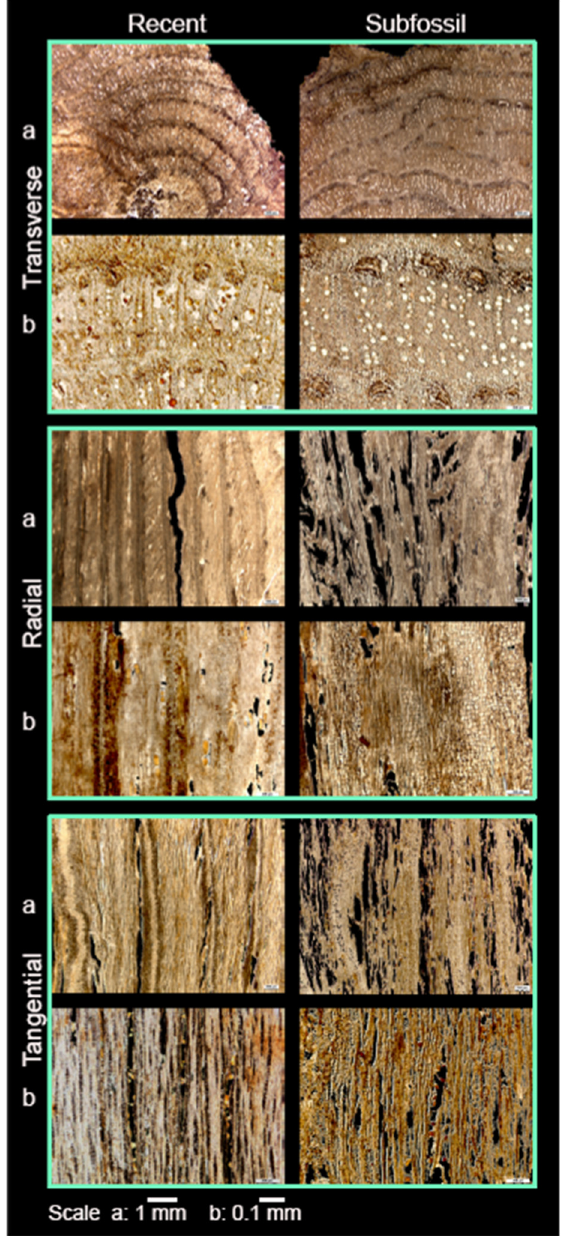
Figure 4. Thin sections of recent Avicennia marina wood (left column) for comparison with the subfossil trench wood (right column), in the transverse, radial, and tangential sections at 1.25 × ( a ) or 5.0 × ( b ) magnification. Section thickness is 20 µ m. The letters a and b refer to the scale bars at the bottom of the figure.